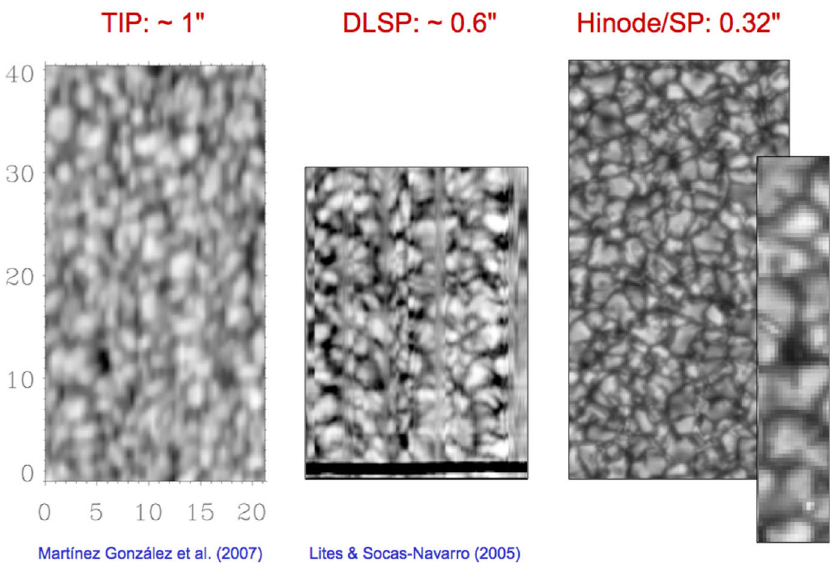
Fig.6 Evolution of the spatial resolution of spectropolarimetric measurements. From left to right we show continuum intensity maps of the quiet solar surface near the disk center observed with TIP at 1565 nm, the DLSP at 630 nm, and the Hinode SP at 630 nm. The TIP and DLSP observations were made from the ground and reach resolutions of 1 (cid:2)(cid:2) and 0 . 6 (cid:2)(cid:2) , respectively (Martínez González et al. 2007; Lites and Socas-Navarro 2004). The Hinode SP performs observations at 0 . 32 (cid:2)(cid:2) . Images reproduced with permission, copyright by ESO (left) and AAS (middle)